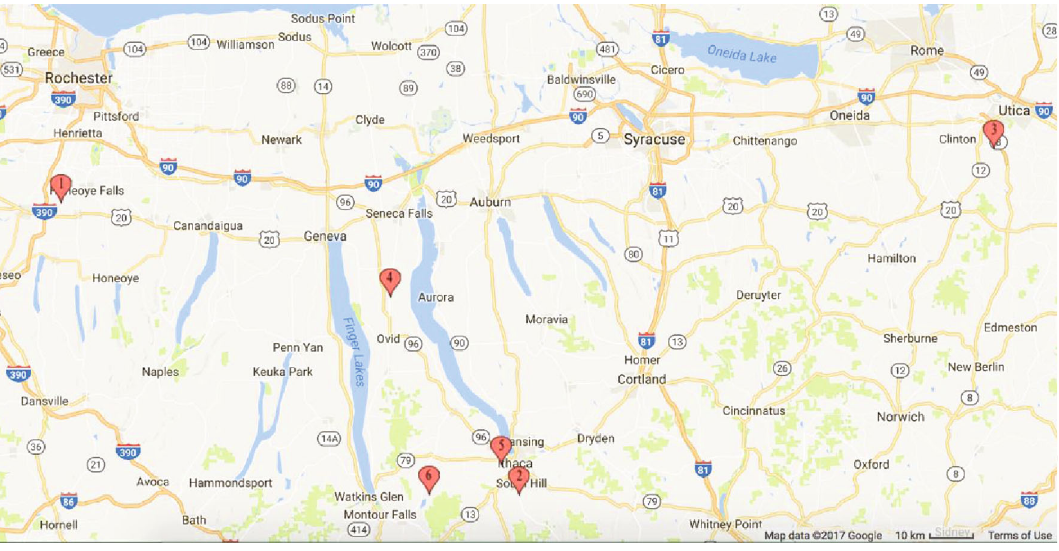
Figure 3: Location of six pole-mounted solar PV systems. Table 1: Detectors used in for each of our 5 data sources.